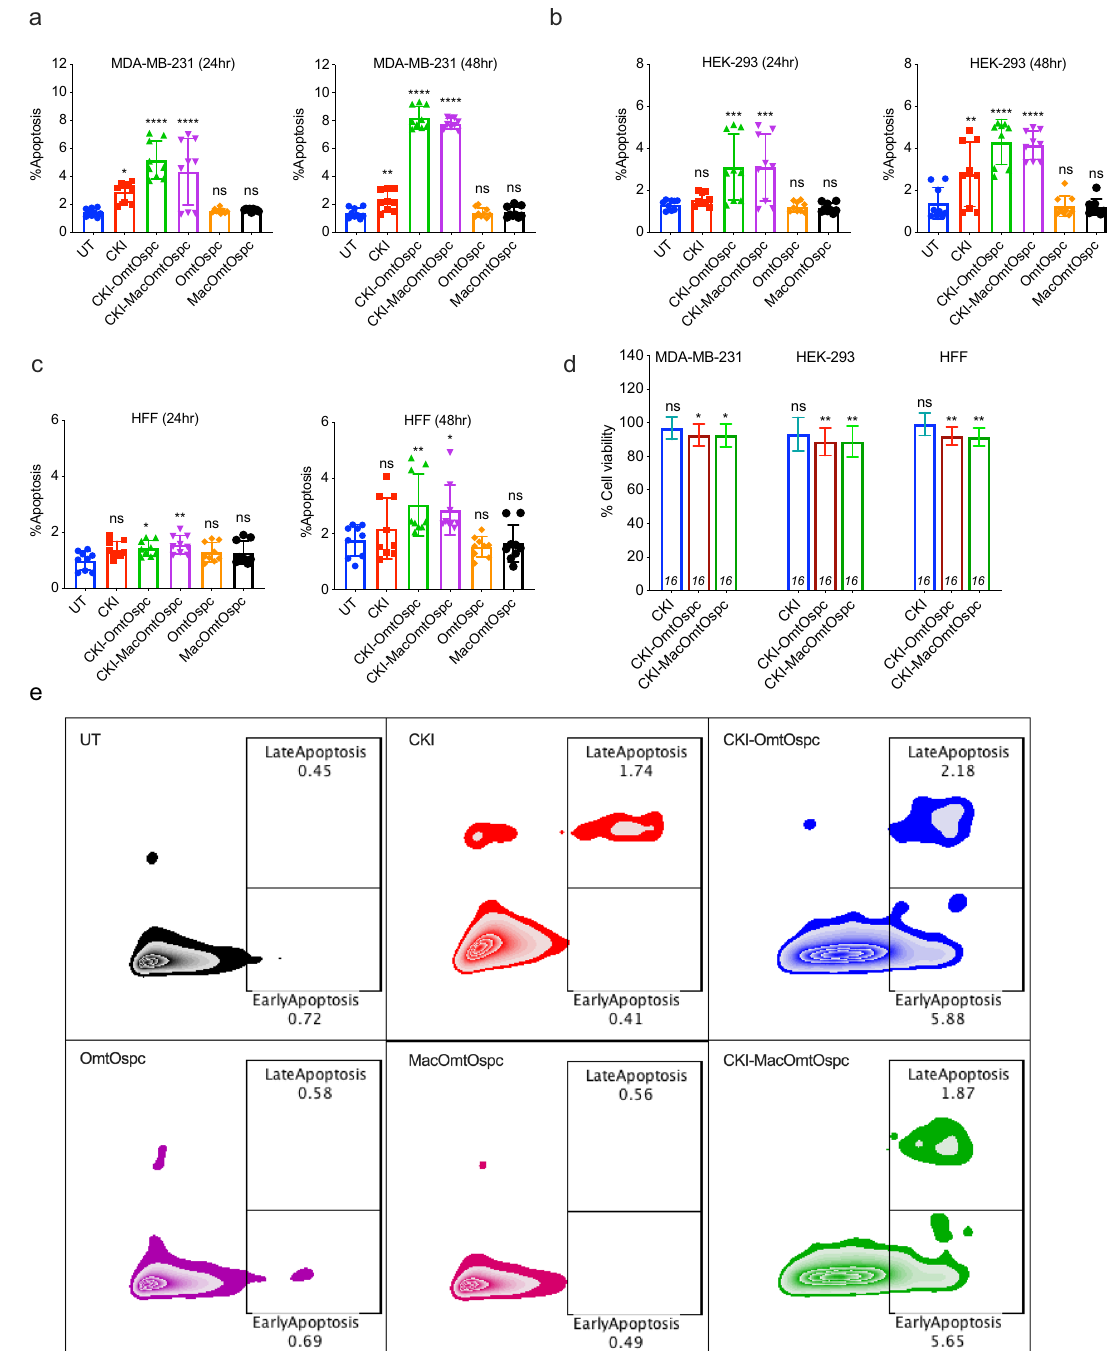
Figure 3. Apoptosis and cytotoxicity assays of subtractive fractions at 24- and 48-hour time point treatments. Apoptotic effect of CKI-OmtOspc, CKI-MacOmtOspc subtractive fractions, OmtOspc and MacOmtOspc in ( a ) MDA-MB-231 cells, ( b ) HEK-293 cells, and ( c ) HFF cells as determined by AnnexinV/PI assay. ( d ) Cytotoxic effect of CKI, CKI-OmtOspc and CKI-MacOmtOspc subtractive fractions was determined using Alamar Blue cytotoxicity assay. All treatments were compared against UT. ( e ) Representative plots of Annexin V and PI staining in MDA-MB-231. Statistically significant results shown as ( * )P < 0.05 or ( ** )P < 0.01 or ( *** )P < 0.001 or ( **** )P < 0.0001; ns (not significant). All data were shown as mean ±